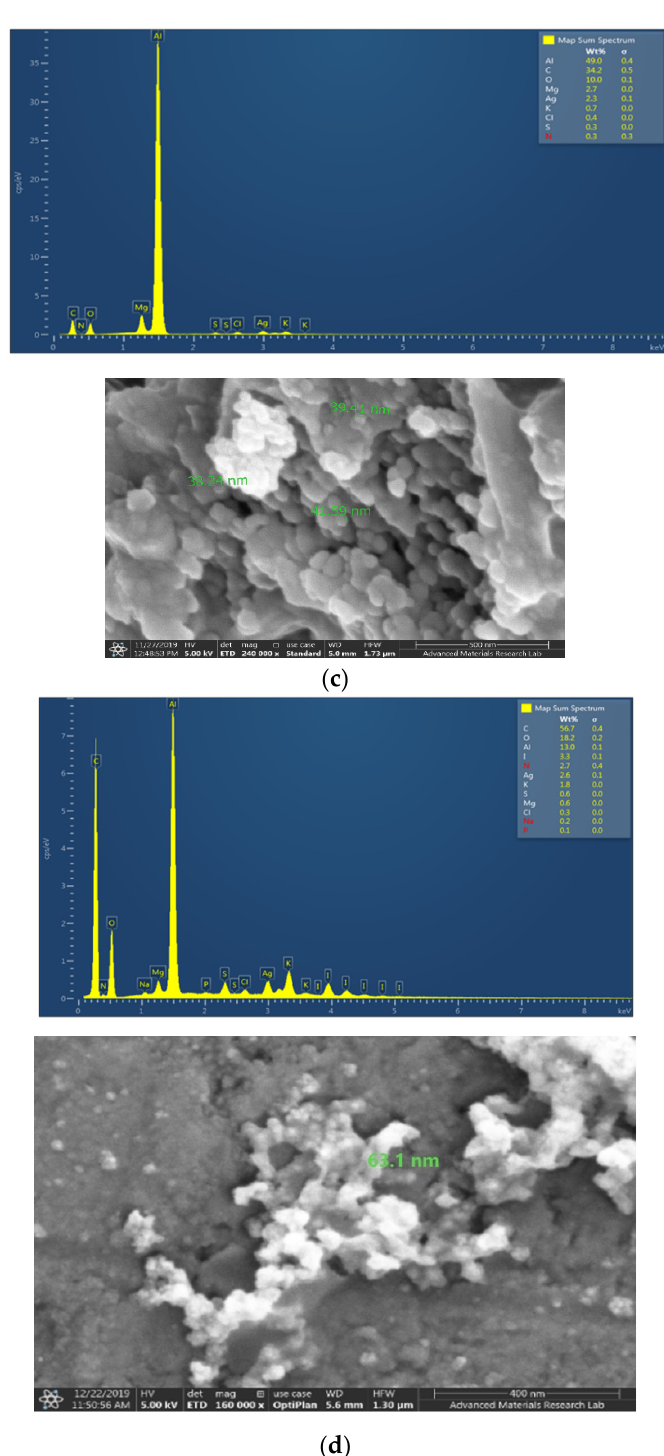
Figure 1. Energy dispersive spectroscopy (EDS) and corresponding scanning electron microscopy (SEM) of the four samples with trans -cinnamic acid (TCA), silver nanoparticles (AgNP), cinnamomum zeylanicum extract (Cinn) and povidone iodine (PI). From up to down: ( a ) TCA-AgNP; ( b ) Cinn-AgNP; ( c ) TCA-AgNP-PI; ( d ) Cinn-AgNP-PI. Figure 2. SEM of medical Polyglycolic Acid (PGA) sutures. From left to right: ( a ) Control (plain PGA suture); sutures coated with ( b ) TCA-AgNP; ( c ) Cinn-AgNP; ( d ) TCA-AgNP-PI; ( e ) Cinn-AgNP-PI.